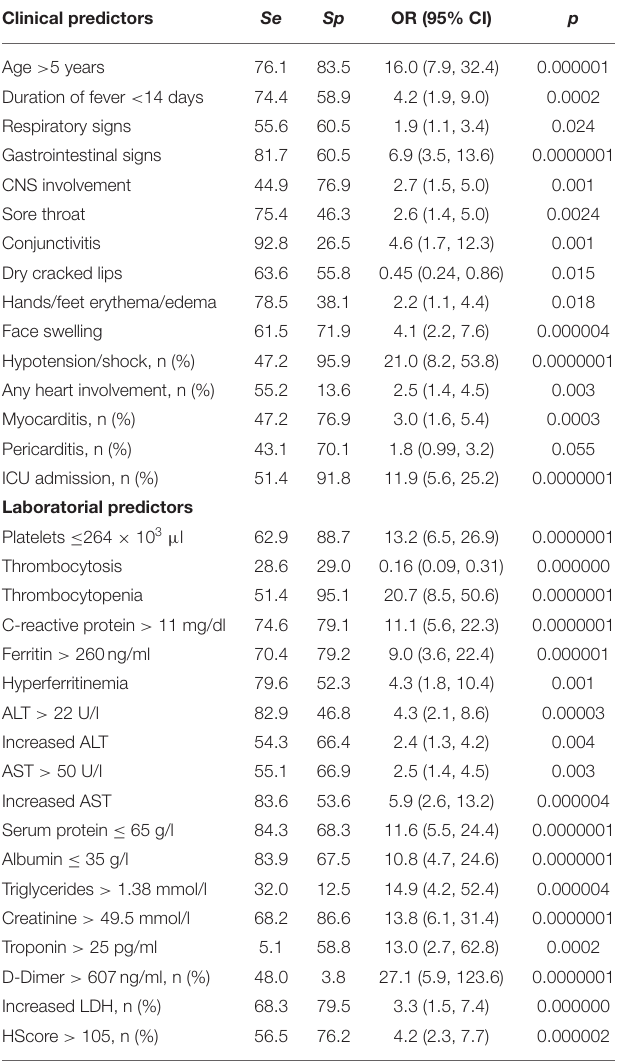
TABLE 2 | Sensitivity, specificity, and odds ratios of clinical and laboratorial predictors, allowing to discriminate MIS-C and KD. Clinical